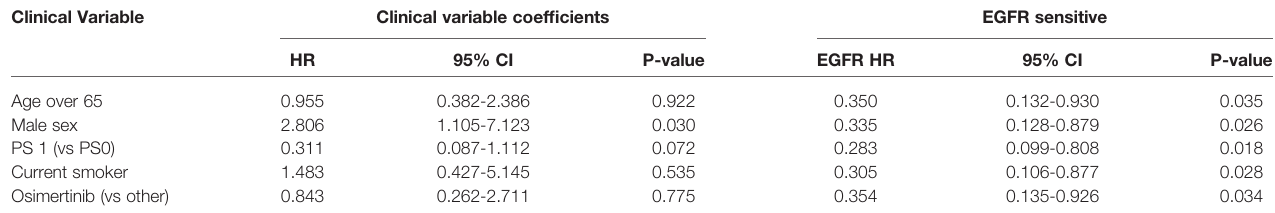
TABLE 2C | Bivariable OS.